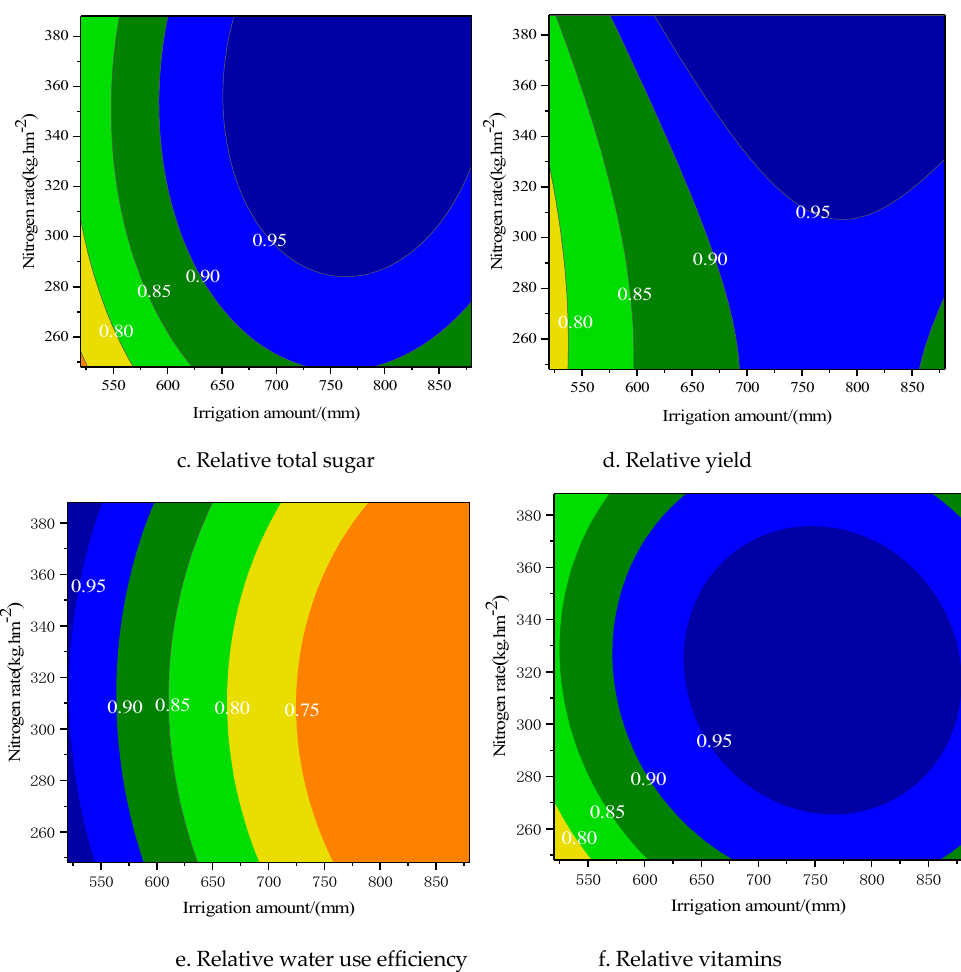
Figure 6. Relationships between water and nitrogen inputs and relative economic benefit, partial productivity of relative nitrogen fertilizer, relative total sugar, relative yield, relative water use efficiency, and relative vitamin C. Note: 0.95, 0.9, 0.85, 0.8, and 0.75 mean ratio of each index of its maximum value.